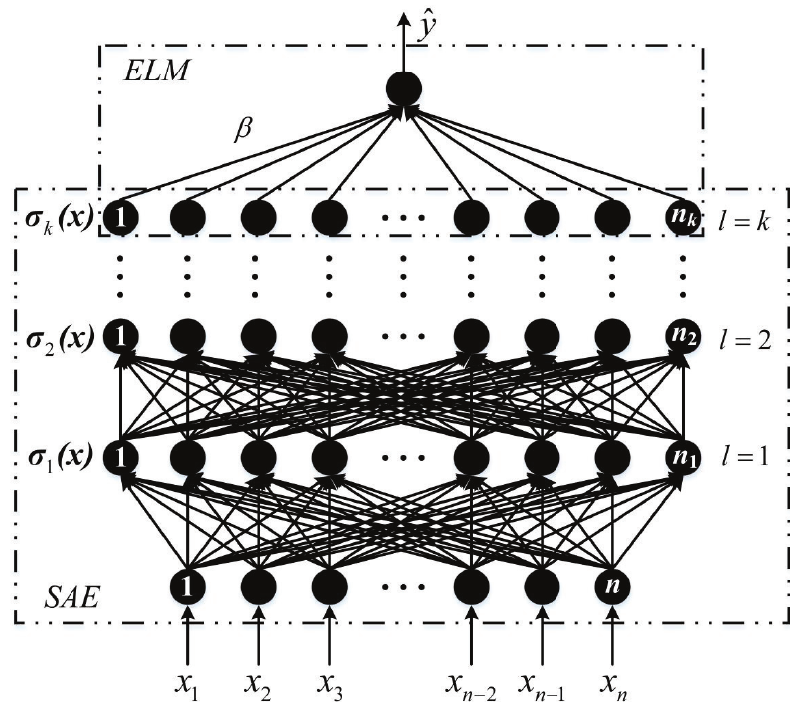
Figure 3. The structure of the extreme SAE with k hidden